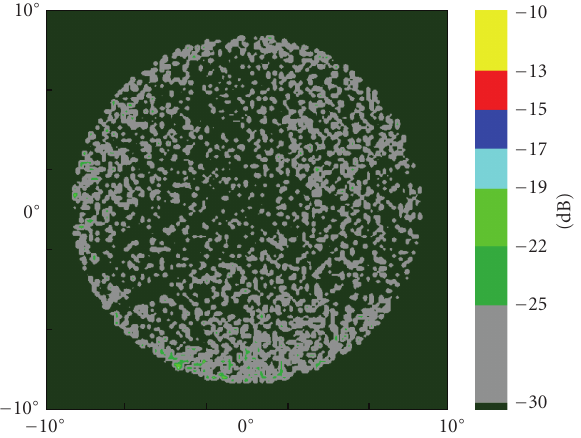
Figure 7: Minimum isolation of DBS beams biased for isolation, 7 colour, with errors, (scale − 31 to − 10dB).